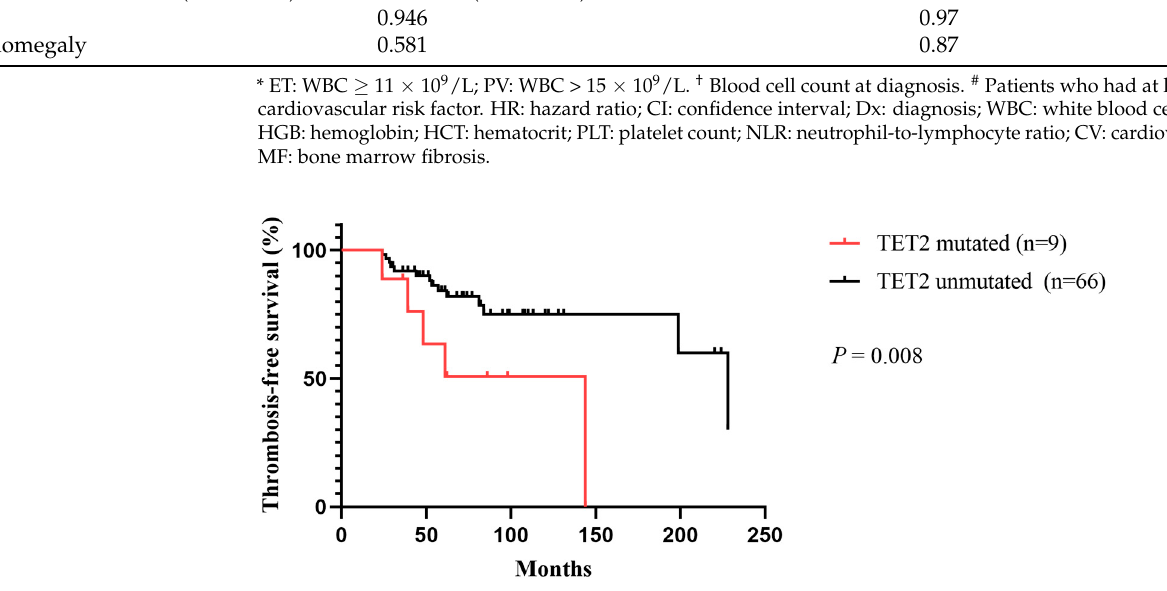
(eight males and seven females). The details of the 15 MPN patients with TET2